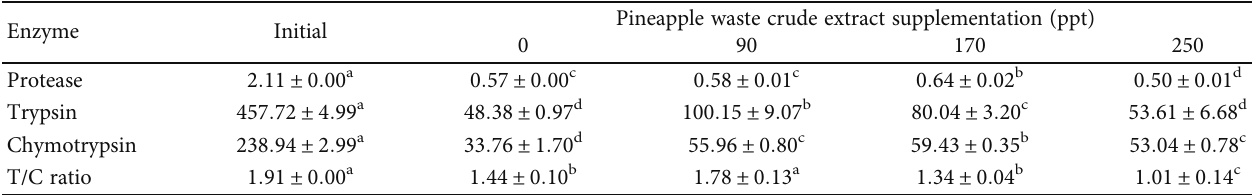
Table 5: Digestive enzyme activity (U/mg protein/min) from hepatopancreas of Paci fi c white shrimp fed with pineapple waste crude extract supplementation diet at di ff erent levels for 80 days.